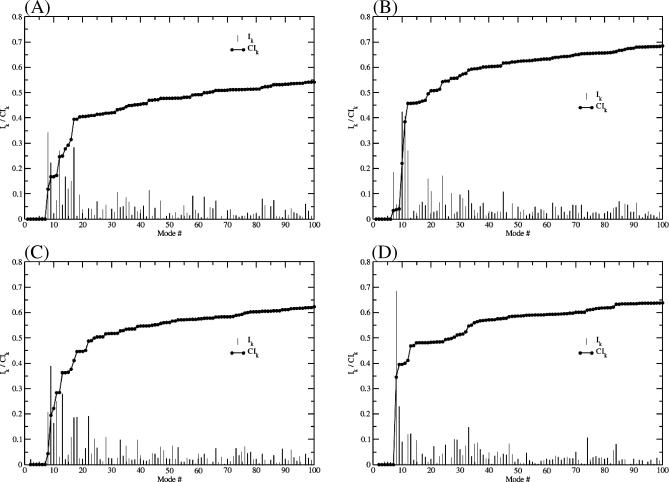
Involvement Coefficient (Ik) and Cumulative Involvement Coefficient (CIk) from the Normal Mode Calculations (Equations 1 and 2)(A) The Ik/CIk are calculated based on the normal modes obtained for 1FMW and mapped onto 1VOM.(B) The Ik/CIk are calculated based on the normal modes obtained for 1VOM and mapped onto 1Q5G.(C) The Ik/CIk are calculated based on the normal modes obtained for 1Q5G and mapped onto 1FMW.(D) The Ik/CIk are calculated based on the normal modes obtained for 1VOM and mapped onto 1FMW.